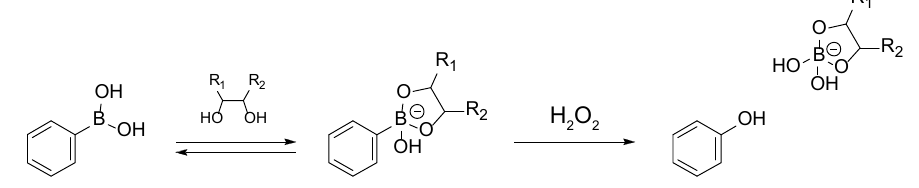
Figure 1. Sequential equilibrium and oxidation reactions of phenyl boronic acid with a diol and H 2 O 2 , respectively.